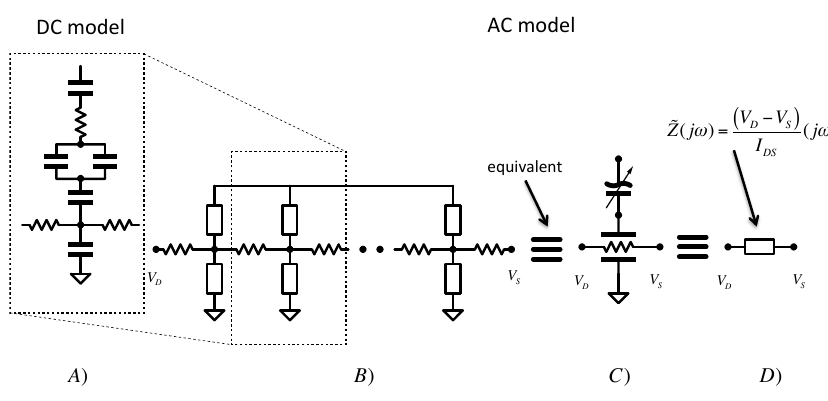
Figure 3. ( A ) DC-sensing model described in previous section; ( B ) AC-sensing model defined by composing a distributed model element based on previous one; ( C ) Compact representation of the AC-sensing model; ( D ) Complex impedance sensed in or